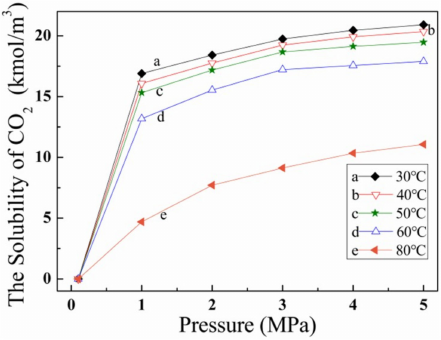
Figure 6. The solubility of CO 2 for a CO 2 –H 2 O system at different temperatures and